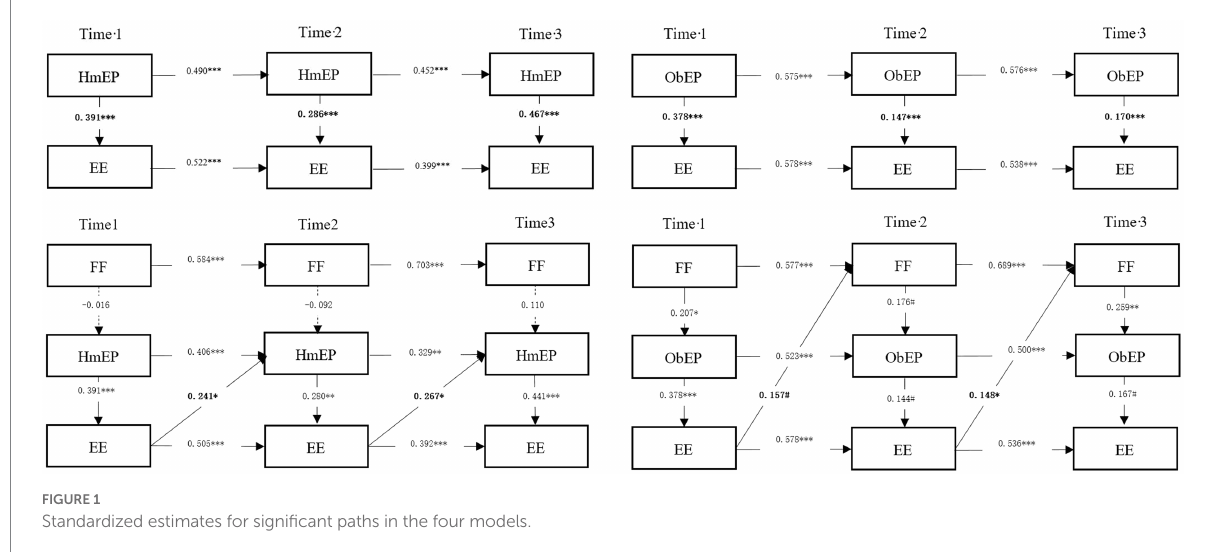
FIGURE 1 Standardized estimates for significant paths in the four